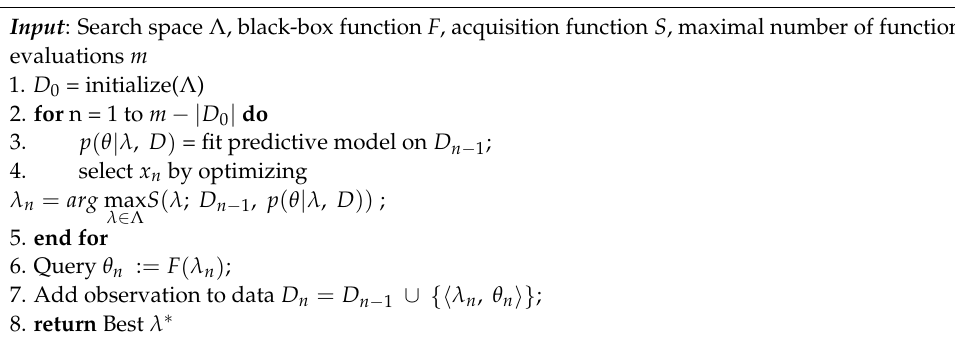
Algorithm 1 Bayesian Optimization (BO)